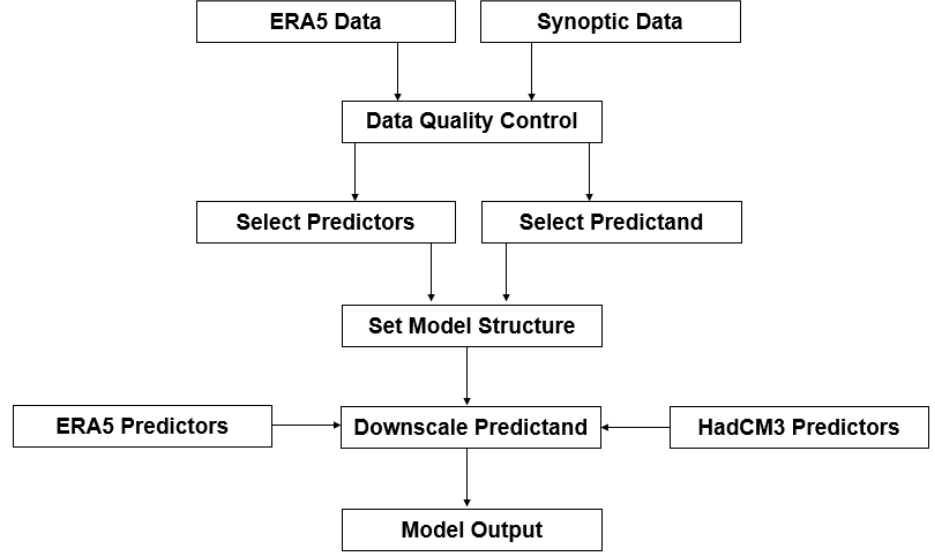
Figure 2. The process of downscaling and production of the scenarios. The process of downscaling and predicting in this model consists of six steps. (1) Data gathering and quality control, (2) selection of appropriate predictor variables, (3) model training, (4) production of current meteorological data using observable variables, (5) sta- tistical analysis of observed data, and (6) production of future meteorological data using the predictor variables [40].